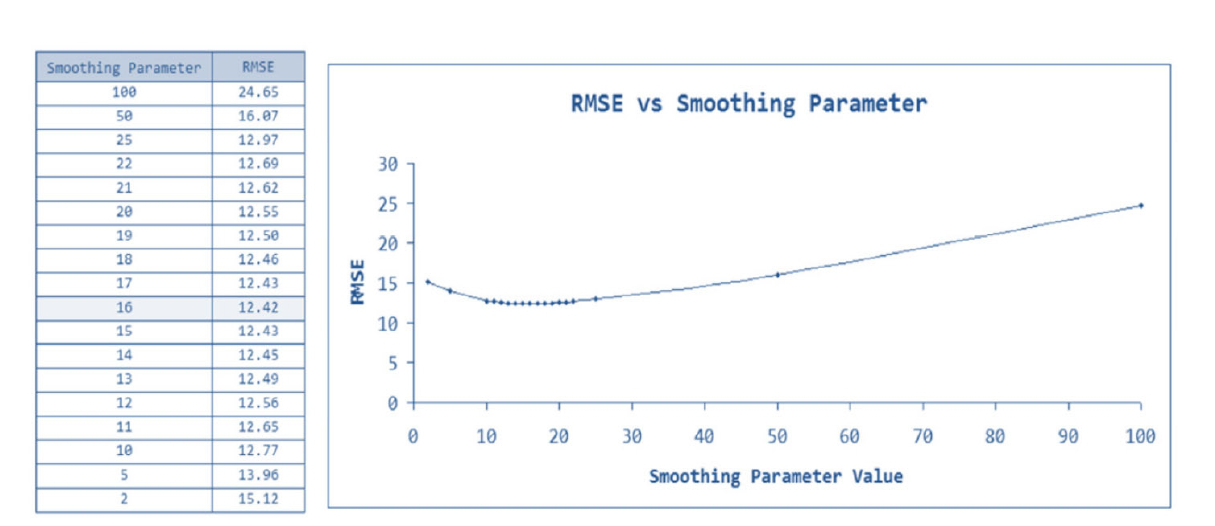
Figure 8. RMSE of the GRNN forecasting model using the IHO